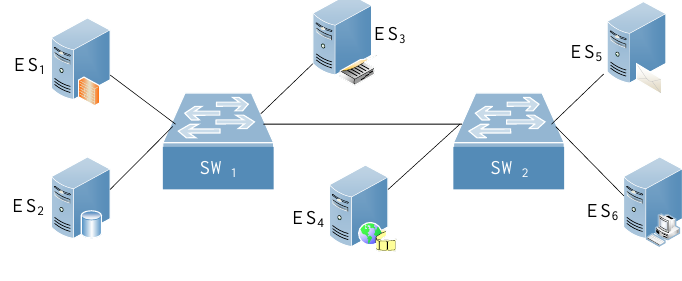
Figure 11. TTEthernet topology. Table 1. The details of TT and RC flows.